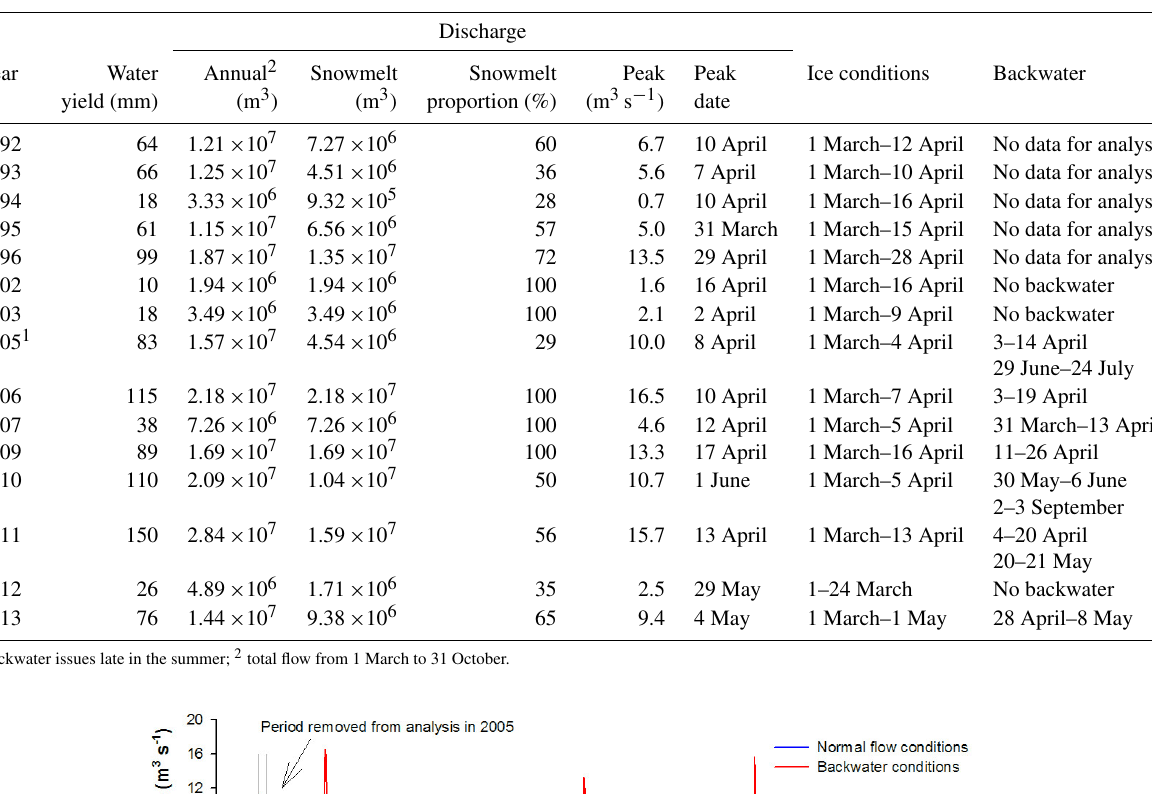
Table 3. Streamflow characteristics of the study area for the years used in the analysis.